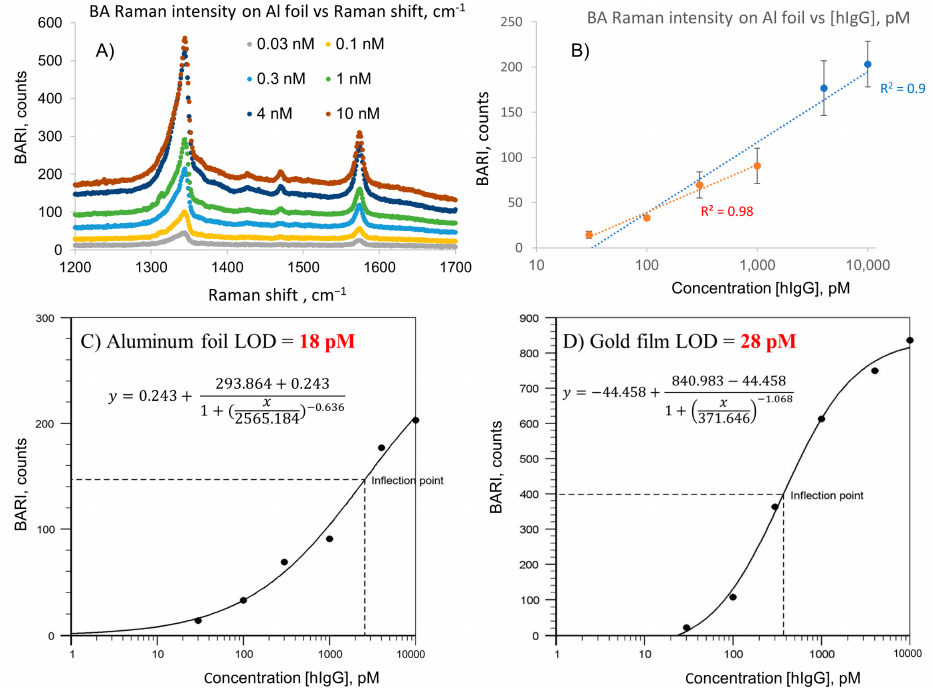
Figure 3. SERS spectra and logarithmic calibration plot of sandwich SERS immunoassays of human IgG on Al foil ( A , B ). Four-parameter logistic nonlinear regression analysis calibration plots of the